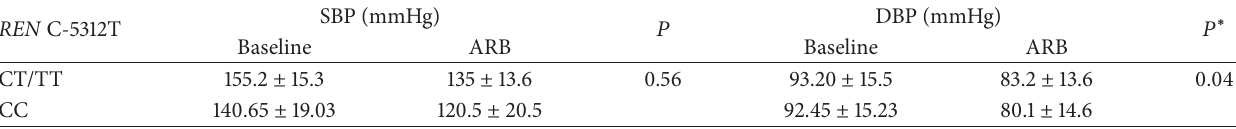
Table 4: Genetic variants of the REN and reduction in blood pressure (valsartan therapy).